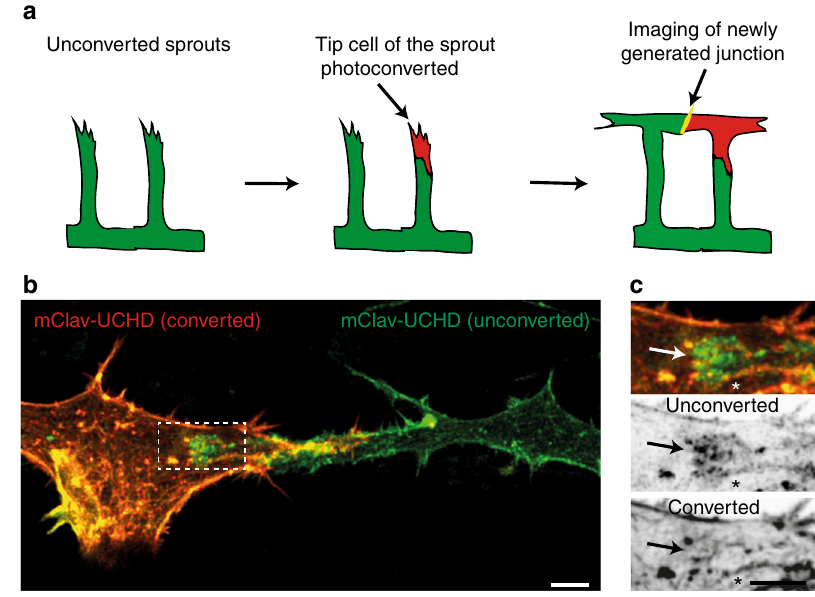
Fig. 4 JBL formation at the distal tip of the junction during DLAV anastomosis. a Schematic representation of the mClav2-UCHD photoconversion experiment. b Image of photoconverted and unconverted mClav2-UCHD cells in the DLAV of an Tg( fl i:Gal4ff ubs3 ; UAS:mClav2-UCHD ubs27 ) embryo, at 32 hpf. c A close up of the inset in b . Arrows point to differentially labeled JBL and asterisk (*) marks the junction outside JBL. Scale bar 5 µ